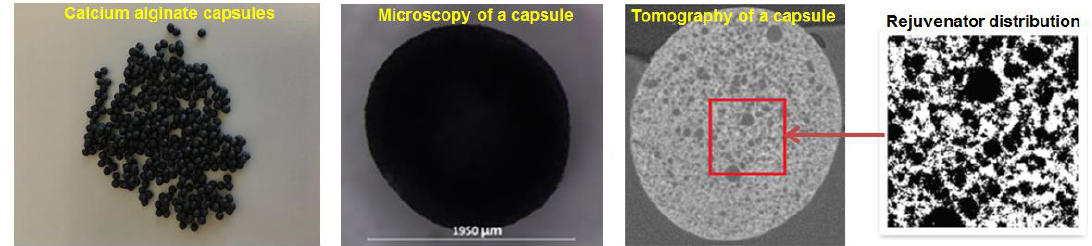
Figure 1. Calcium alginate capsules prepared by Xu et al. [9].